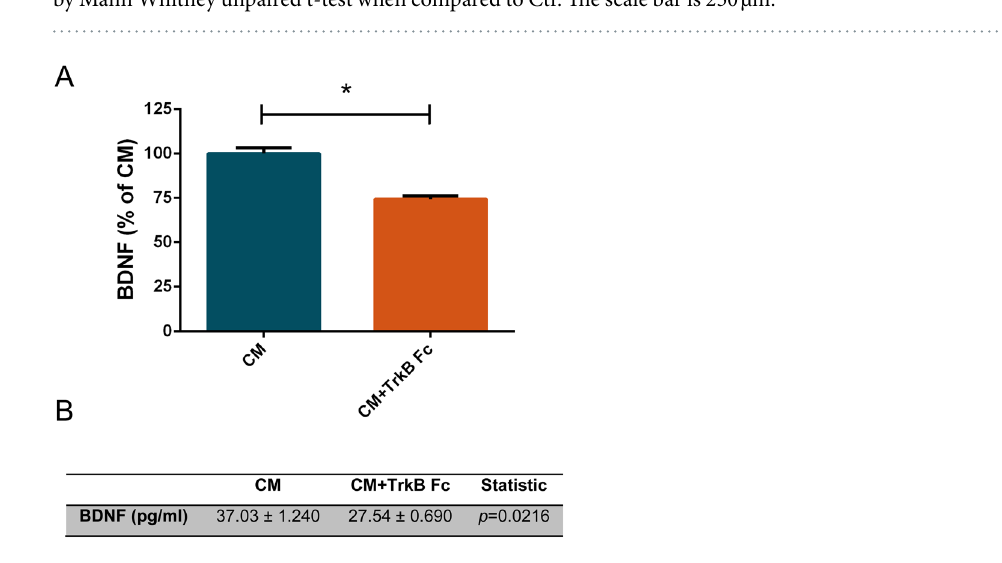
Figure 4. TrkB Fc reduces the levels of BDNF present in CM. ( A ) HUCPVC conditioned media was incubated with TrkB Fc and the levels of BDNF were determined by the Bioplex-Luminex assay. Our results show that TrkB Fc is able to cause a reduction of approximately 25% in the levels of BDNF in CM (74.37 ± 1.86), comparatively to CM (100.0 ± 3.35) proving that TrkB Fc is able to significantly deplete BDNF from CM. ( B ) BDNF concentration in CM is 37 pg/ml. On the other hand, the presence of TrkB Fc, reduces the levels of BDNF present in CM to approximately 27 pg/ml. BDNF levels were measured using a MILLIPLEX Kit. * Represents p = 0.0216 by Mann Whitney unpaired t-test when compared to